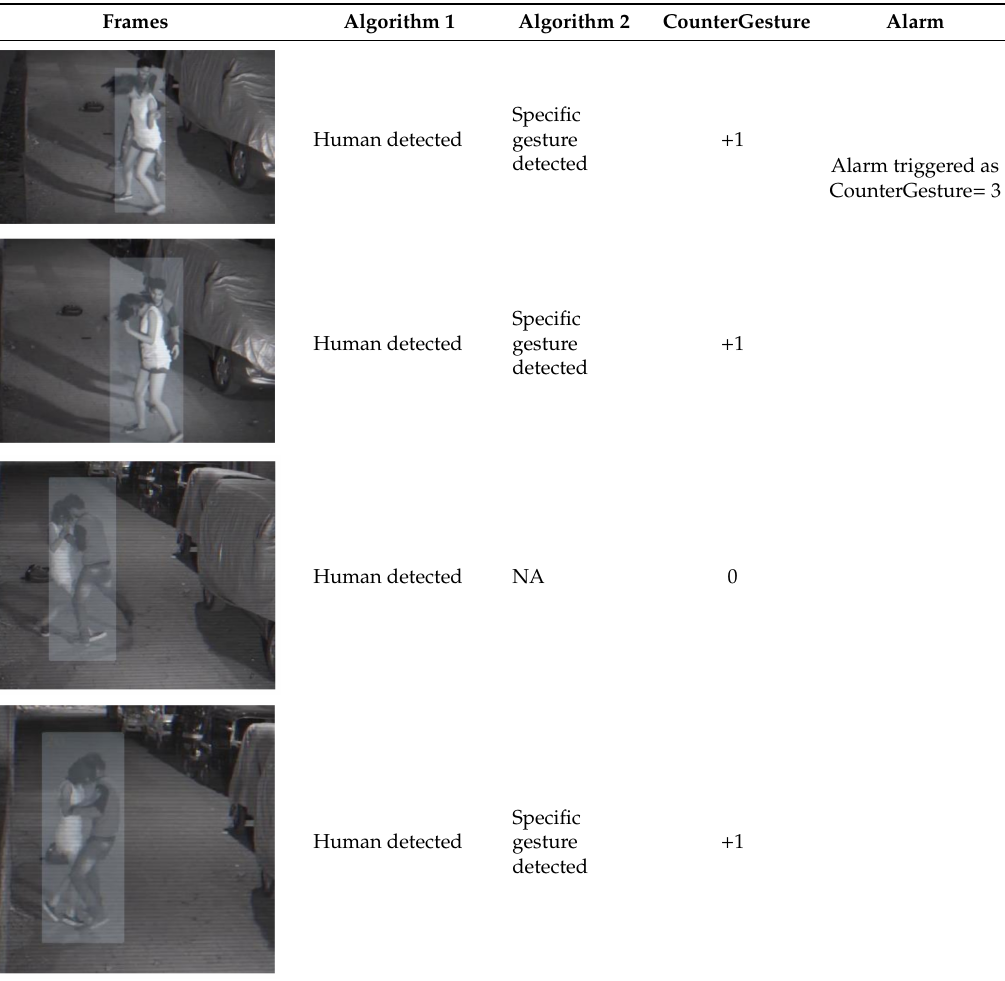
Table 5. Step-by-step application of our algorithms on a sexual assault